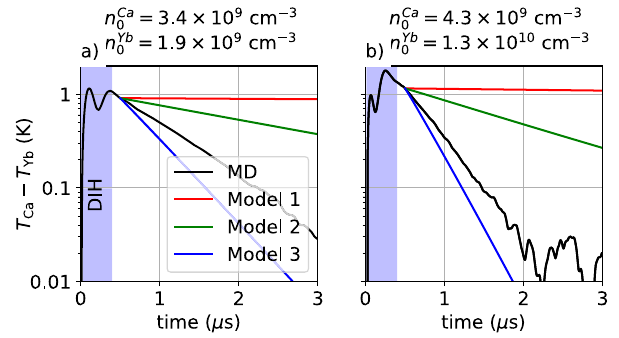
Fig. 4 Temperature differences vs. time. Semi-logarithmic plots of the temperature difference T Ca − T Yb (black line) compared with temperature relaxation models are shown. Model 1 red line, Eqs. (10) – (15), Model 2 green line, Eqs. (17) and (18), Model 3 blue line, Eqs. (19) and (20). Simulation parameters T e = 100 K, a κ = 0.38, b κ = 0.46. The systematic improvement of the models compared to the MD simulation is clearly shown. Data in b is reproduced from L. G. Silvestri, et al., Phys. Plasmas 28, 062302 (2021), with the permission of AIP